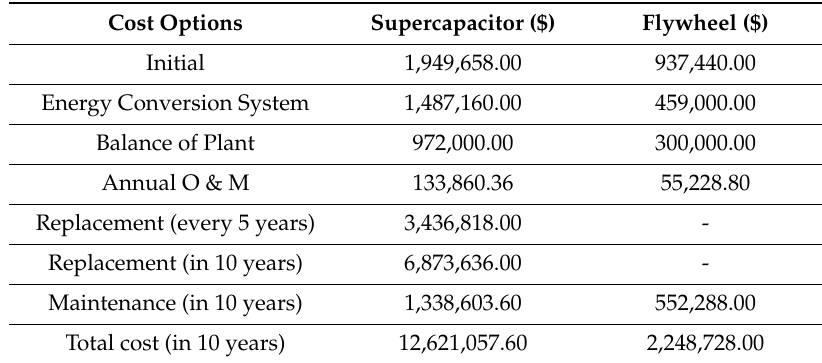
Table 6. Cost analysis for voltage